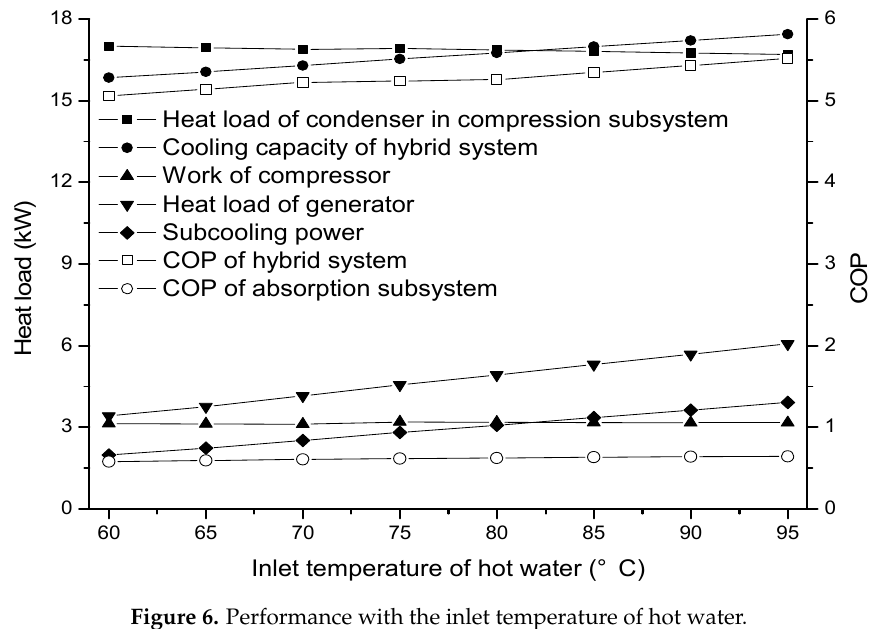
Figure 5. Performance of hybrid system in the design condition.